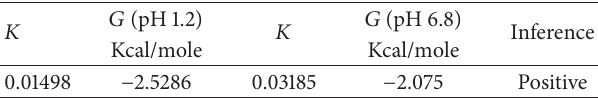
Table 4: Calculation of adsorption energy ( 𝐺 = RTln 𝐾 ). 𝐾